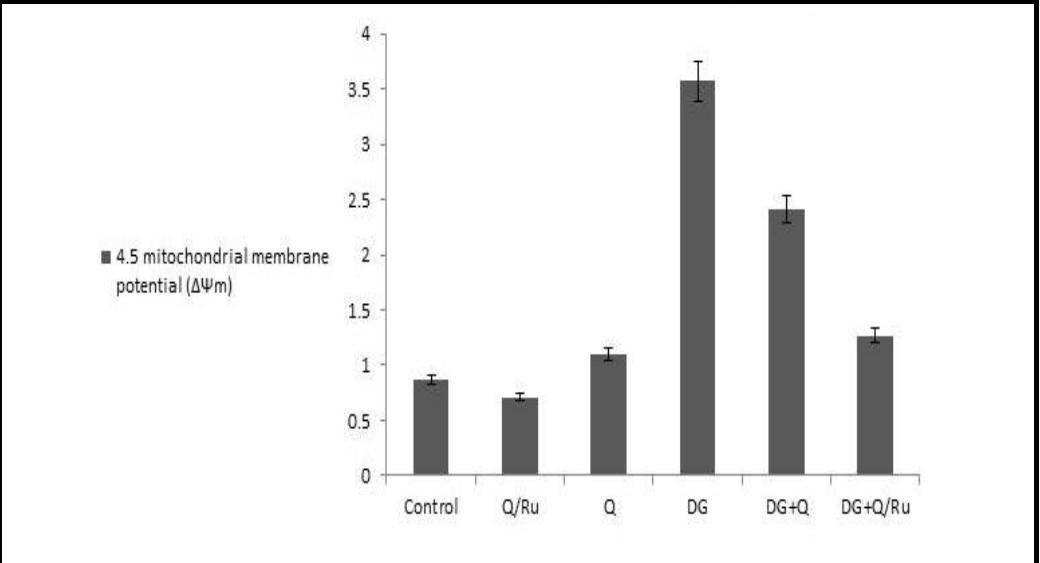
Figure 19. Mitochondrial membrane potential in different treated group with DG, Q and/or Ru III /Q.